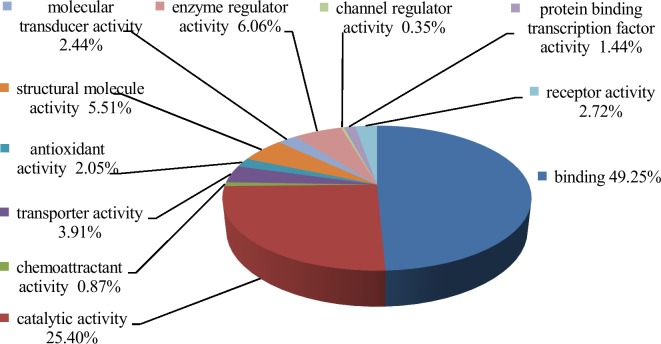
Molecular functions of the total proteins.